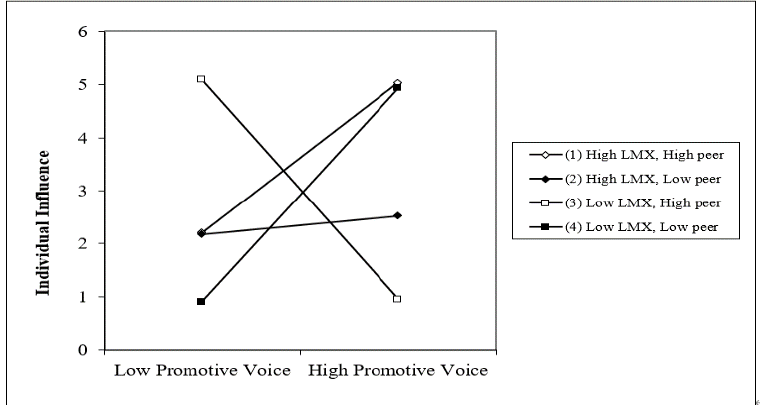
Figure 3. Three-way Interaction of LMX, Peer Relationship, and Promotive Voice.